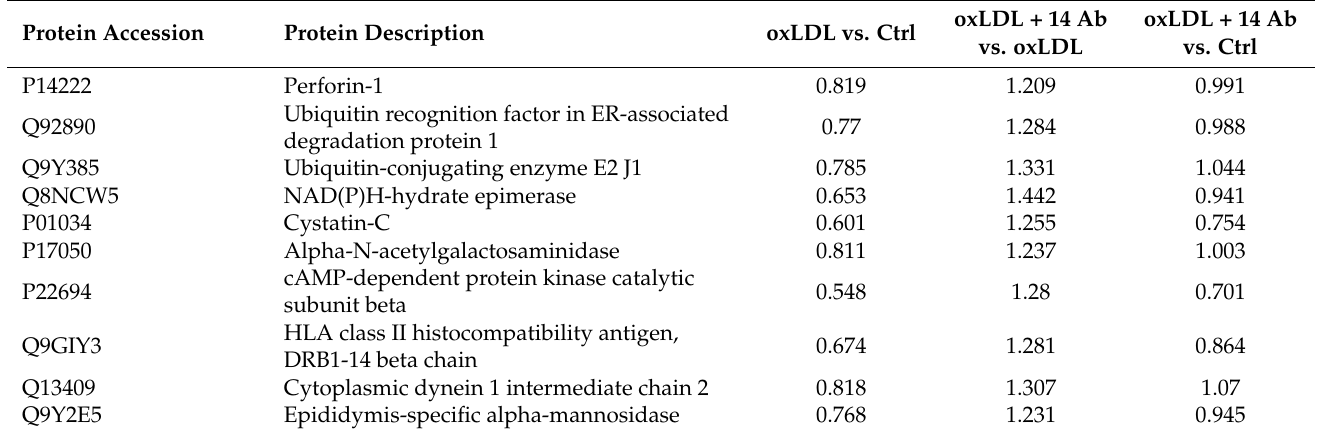
Figure 2. oxLDL reduces MSRA protein expression in THP-1 cells, while recombinant human- ized IgG1 antibody upregulates MSRA expression. CD14 + monocytes were treated with oxLDL (50 µ g/mL) with or without the recombinant humanized IgG1 antibody (14 Ab, 100 µ g/mL) for 48 h and subject to TMT-labeled quantitative proteomics analysis. Only when the variation of proteins’ abundance was more than 1.2 times and t -test p -value < 0.05, were they accepted as differentially expressed proteins. ( A , B ) The number of upregulated and downregulated proteins in pairwise comparison (n = 3). oxLDL, oxidized low-density lipoprotein; TMT, Tandem Mass Tags. Table 1. 16 candidates were screened and exhibited after the intersectional clustering of differentially expressed